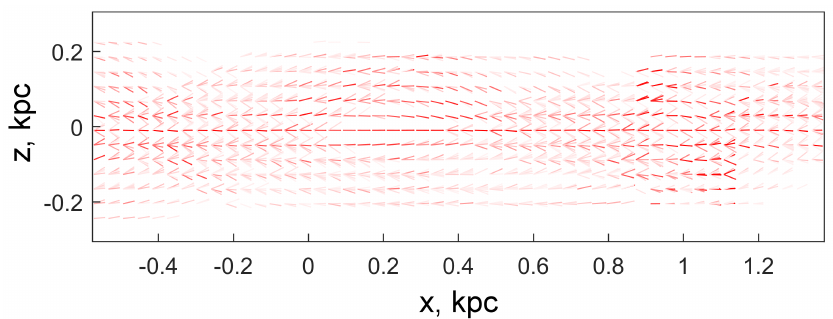
Figure 7. Fields of glyphs of the mean velocities of beams for a large fraction of particles. All glyphs are built for areas of 0.024 × 0.024 kpc (6 × 6 cells). The arrow lengths are proportional to the mean velocity of the beam particles. The color saturation of glyphs characterizes the number of particles in a particular beam according to the Formula (11). Areas with a single beam are marked with a single arrow. In areas of multi-stream flow, several glyphs are displayed simultaneously, characterizing each individual beam.